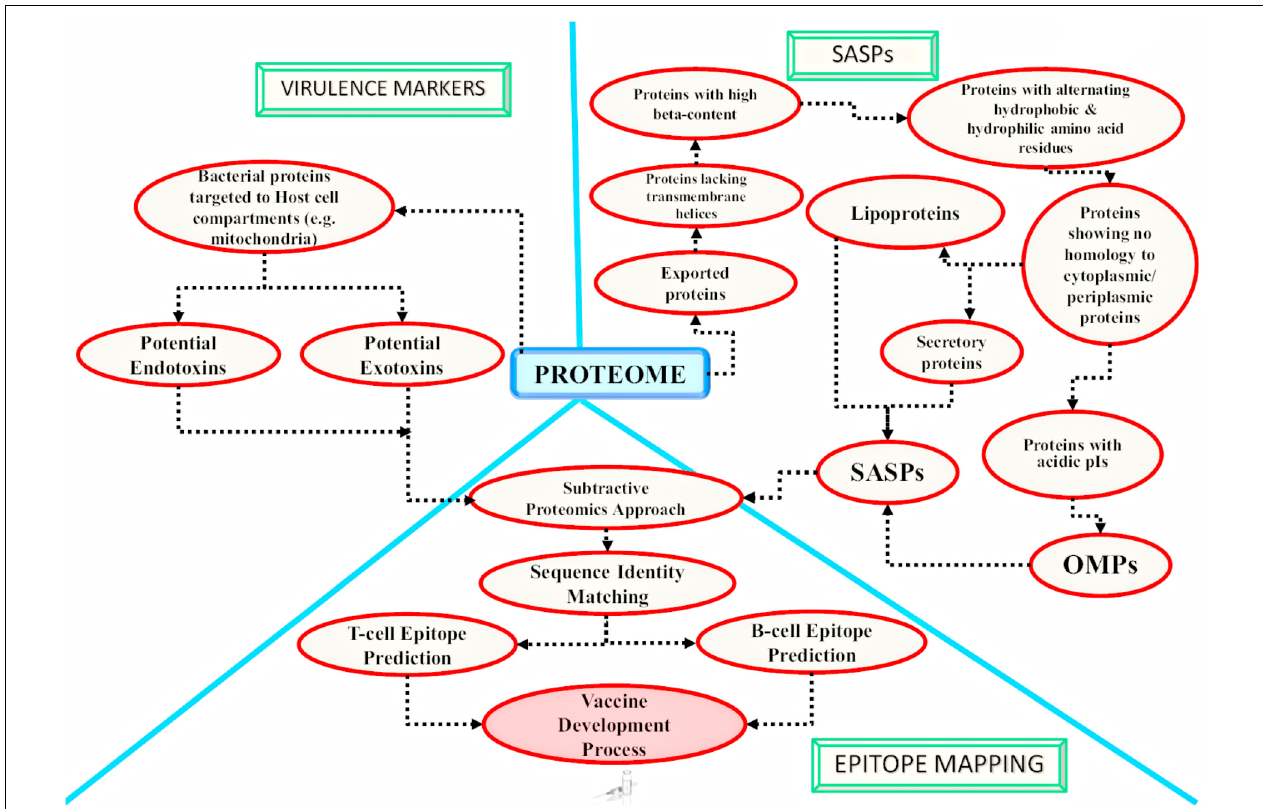
FIGURE 3 | Application of in silico approaches for mycobacterial antigen discovery: a schematic overview of the methodologies currently followed using in silico approaches for mycobacterial antigen discovery is shown here. These antigens may be targeted for developing medical interventions against infectious agents. The bacterial factors targeting the host cell compartments are considered as established virulence factors and are reported to be involved in host cell ‘hijacking’ [as reported for mitochondria targeted M. avium subsp. paratuberculosis (MAP) proteins by Rana et al. (2015b)]. There are computational algorithms available which may further identify potential endotoxins and exotoxins from the potential host targeted proteins. The obtained host targeting proteins can further be subjected to epitope mapping analysis. On the other hand, the complete proteome of the pathogen can also be targeted for the identification of potential surface associated and secretory proteins (SASPs), which include lipoproteins, secretory proteins and Outer Membrane Proteins (OMPs). Epitope mapping may be carried out for the identified SASPs (Rana et al., 2015c). The screened epitopes might be utilized for developing next generation vaccines [e.g., chimeric multi-subunit artificial model vaccine as reported by Rana et al. (2016) and novel serodiagnostic markers]. Similar in silico studies may be targeted to identify novel potential antigens against other infectious agents